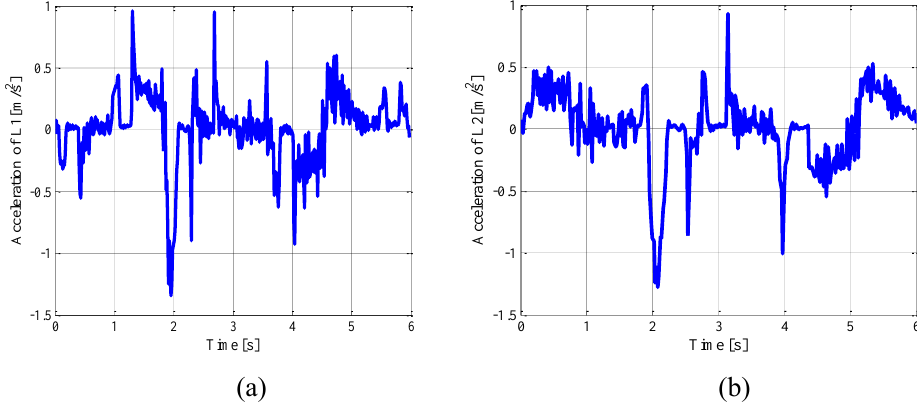
Figure 9. Measured axial linear acceleration along z axis for two linear actuators: (a) actuator L1; (b) actuator